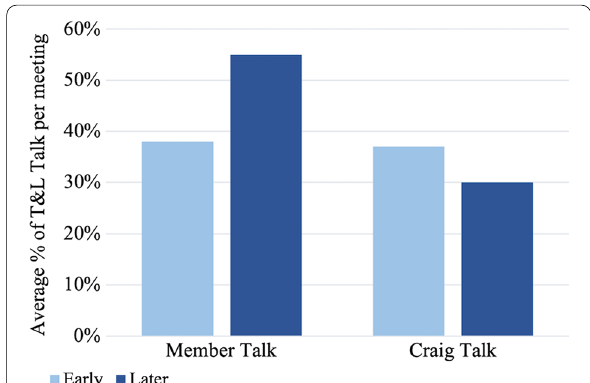
Fig. 6 Average percentage of T&L talk duration of Craig and members during early and later group meetings. Early meetings averaged 60 min (averaging roughly 23 min of member talk and 22 min of Craig talk) and later meetings averaged 55 min (averaging roughly 30 min of member talk and 17 min of Craig talk). Co-facilitator talk is not represented on this graph